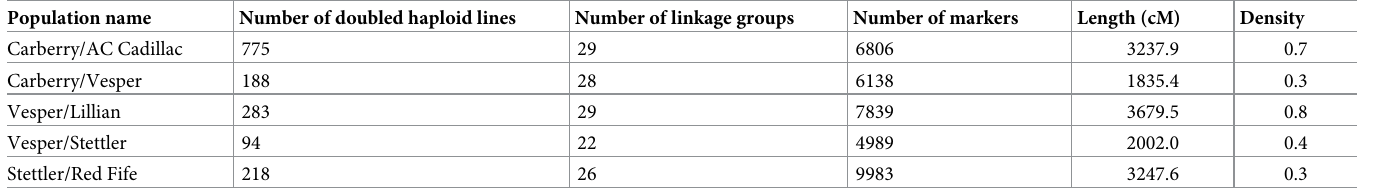
Table 2. Number of lines, number of linkage groups, number of markers, genomic size and map density of five doubled haploid mapping populations used in the leaf rust resistance QTL